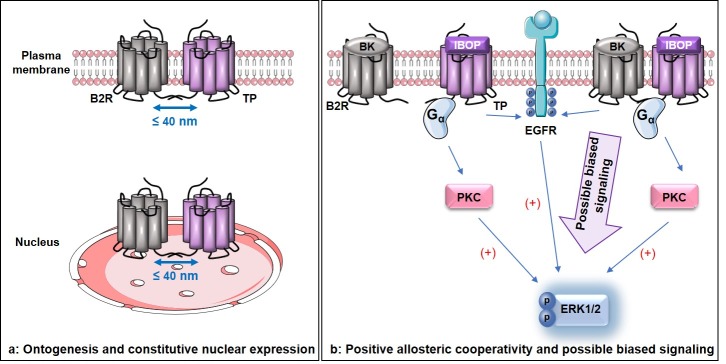
The unique aspects of B2R-TP crosstalk in VSMC.(a): Constitutive B2R-TP interaction exists at the plasma membrane and nuclei implying possible B2R-TP association early during ontogenesis. (b): BK provokes positive allosteric modulation on IBOP resulting in synergistic ERK1/2 signaling possibly mediated via a biased signaling pathway in rat VSMC.